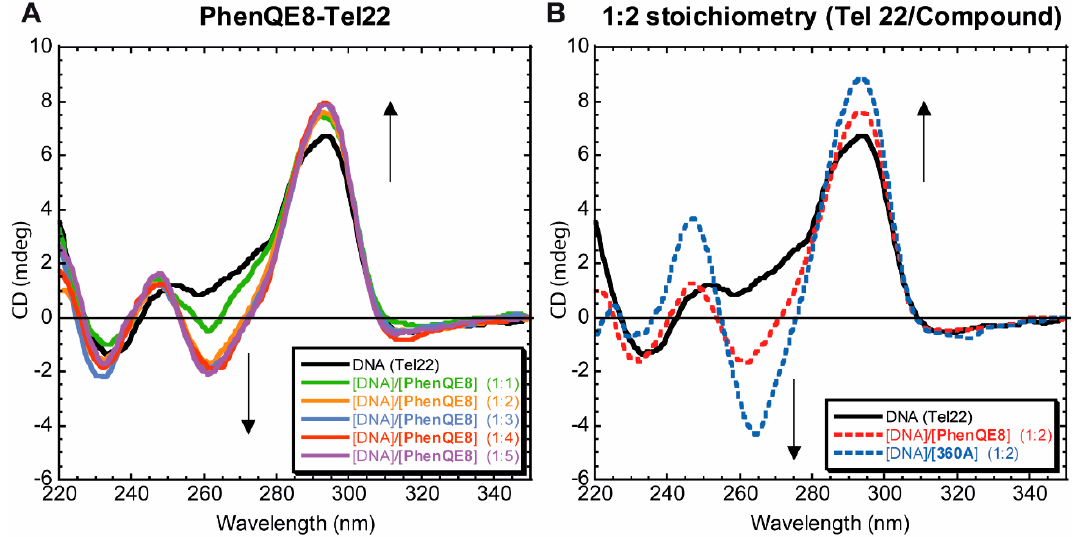
Figure 5. ( A ) Changes in circular dichroism (CD) spectra of quadruplex Tel22 (4 μ M strand molarity), folded in the presence of potassium ions (10 mM lithium cacodylate, 90 mM LiCl, 10 mM KCl, pH 7.3, 25 °C) upon addition of PhenQE8 in a molar ratio quadruplex DNA/PhenQE8 ranging from 1:1 to 1:5. ( B ) CD changes at 1:2 Tel22/ligand stoichiometry for PhenQE8 and reference compound 360A.